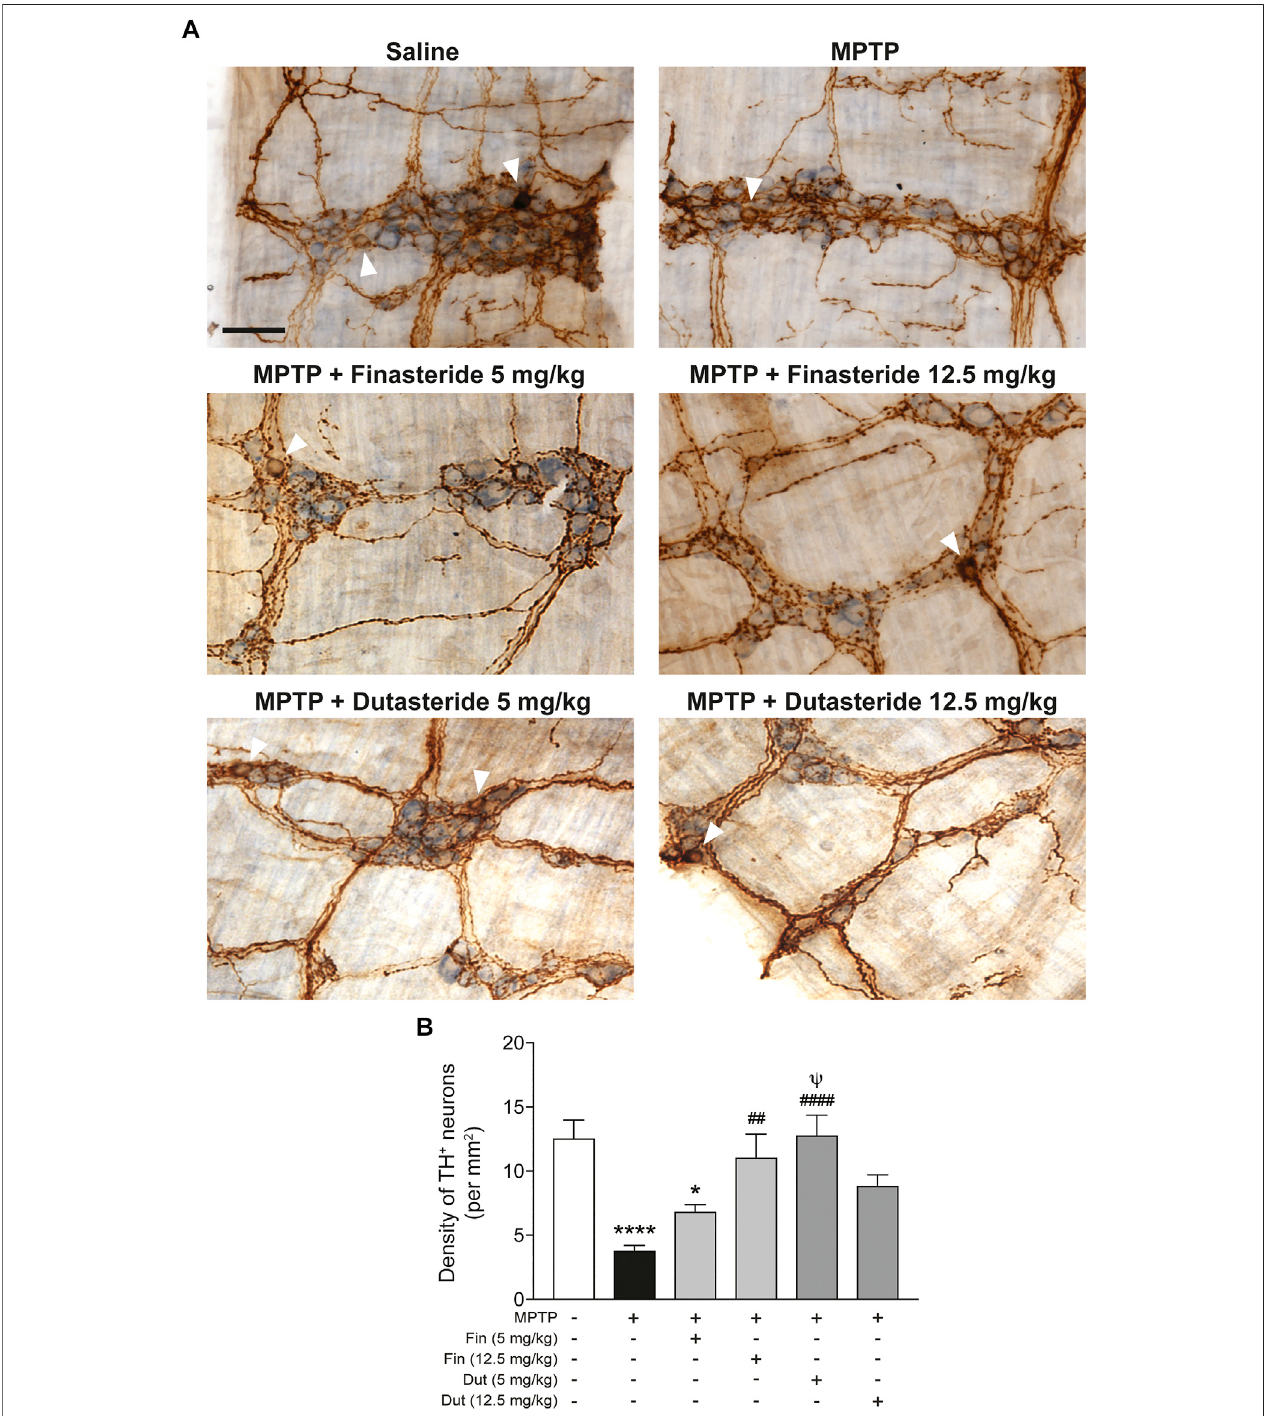
FIGURE 1 | Finasteride and dutasteride treatments prevented MPTP-induced DA neurons damage in the myenteric plexus. (A) Photomicrographs of neuronal ganglia (light blue staining) and TH immunochemistry staining (brown DAB staining) in the myenteric plexus of the distal ileum. The white arrowheads indicate TH + cell bodies; scale bar = 25 µm. (B) Stereological counts of TH + neurons in the myenteric plexus showed neuroprotective effect of fi nasteride (Fin) (12.5 mg/kg) and dutasteride(Dut) (5 mg/kg) inMPTP mice.Values shown aretheaveragedensities (permm 2 )± SEMof10mice per group. * p < 0.05 and **** p < 0.0001compared to saline control mice; ## p < 0.01 and #### p < 0.0001 compared to MPTP lesioned mice; ψ p < 0.05 compared to MPTP + fi nasteride (5 mg/kg) treated mice.